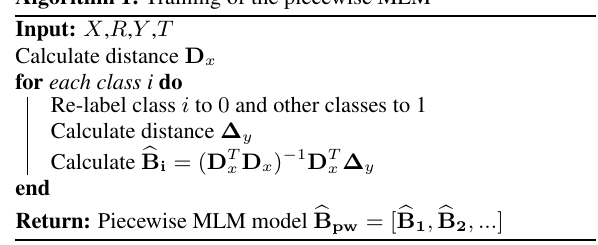
Algorithm 1: Training of the piecewise MLM